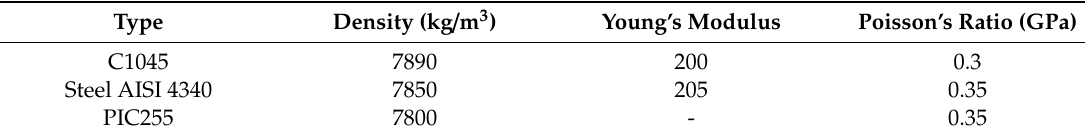
Table 3. The basic characteristics of C1045 and Steel AISI 4340.